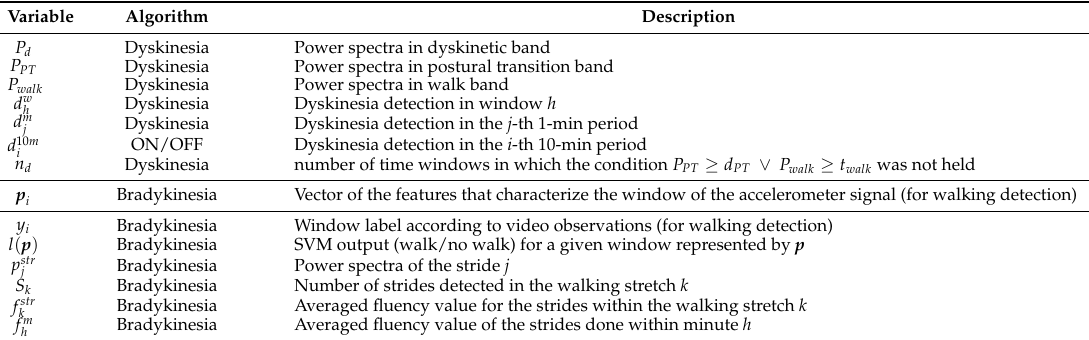
Table 4. Summary of the variables used in this work.